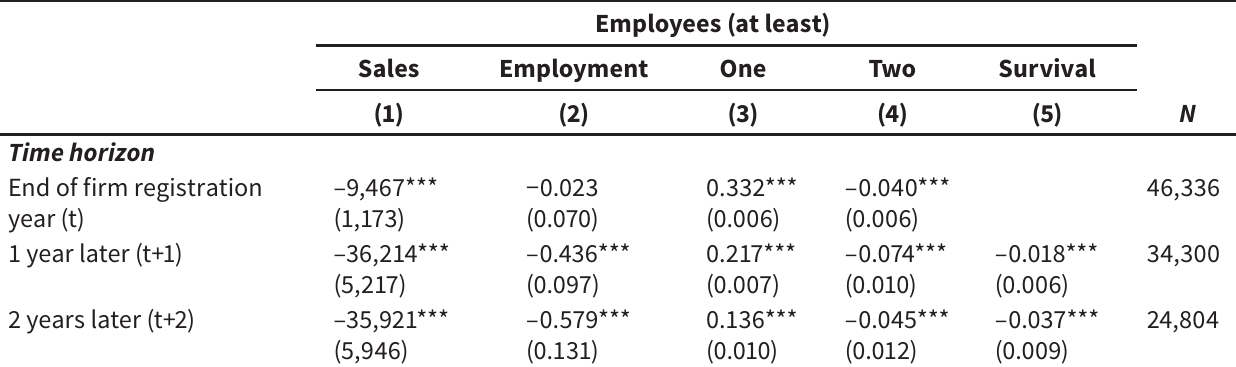
Regression results for limited liability